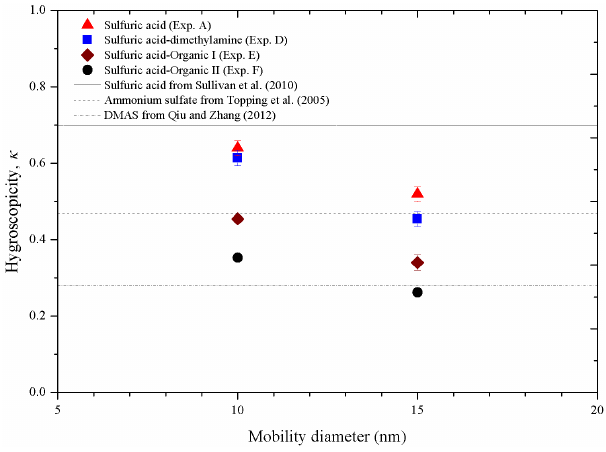
Figure 2. Comparison of the hygroscopicity ( κ ) for 10 and 15nm particles in the presence of sulfuric acid (Exp. A), sulfuric acid– dimethylamine (Exp. D), and sulfuric acid–organics produced by α -pinene oxidation with OH scavenger (Exps. E–F). The theoreti- cal κ of sulfuric acid (solid line) from Sullivan et al. (2010), κ of ammonium sulfate (dashed line) from Topping et al. (2005), and κ of DMAS (dashed dotted line) from Qiu and Zhang (2012) are also presented. The α -pinene concentrations during sulfuric acid– organic I and sulfuric acid–organic II were 420 and 910ppt, re- spectively, as can be seen in Table 1. Error bars show a standard deviation from measurements